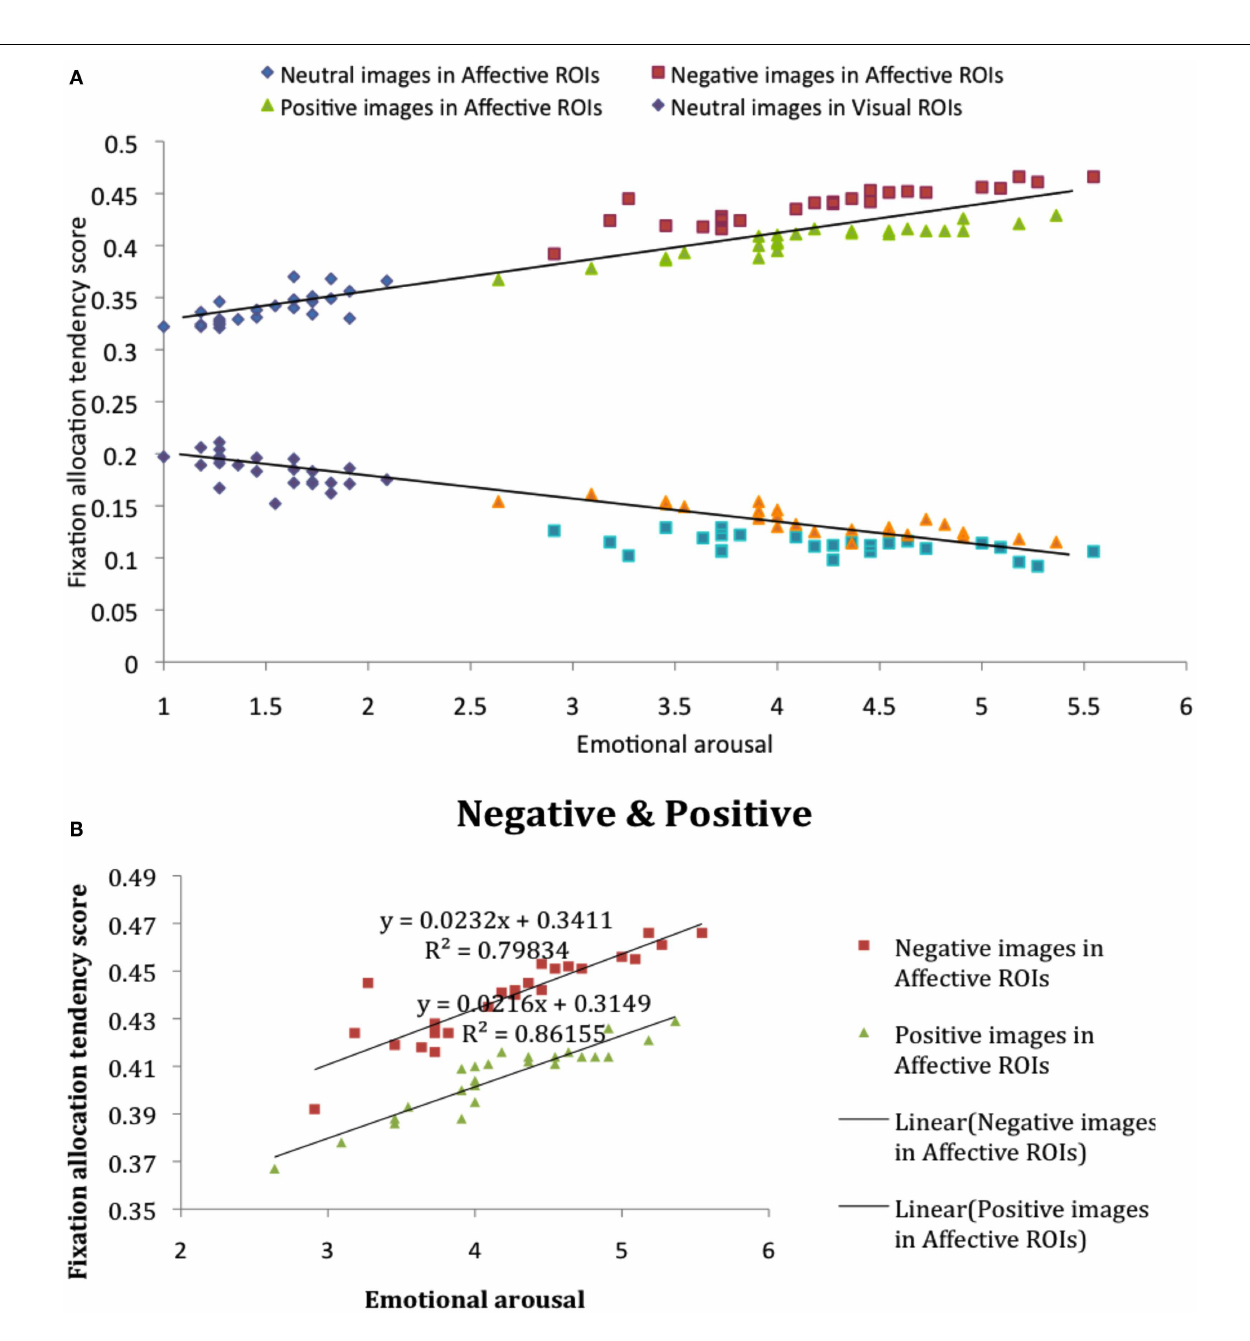
FIGURE 3 | (A) Fixation allocation tendency scores in affective and visual ROIs, image by image, as a function of participant-rated emotional salience. (B) Fixation allocation tendency scores in affective ROIs for negative and positive image categories.